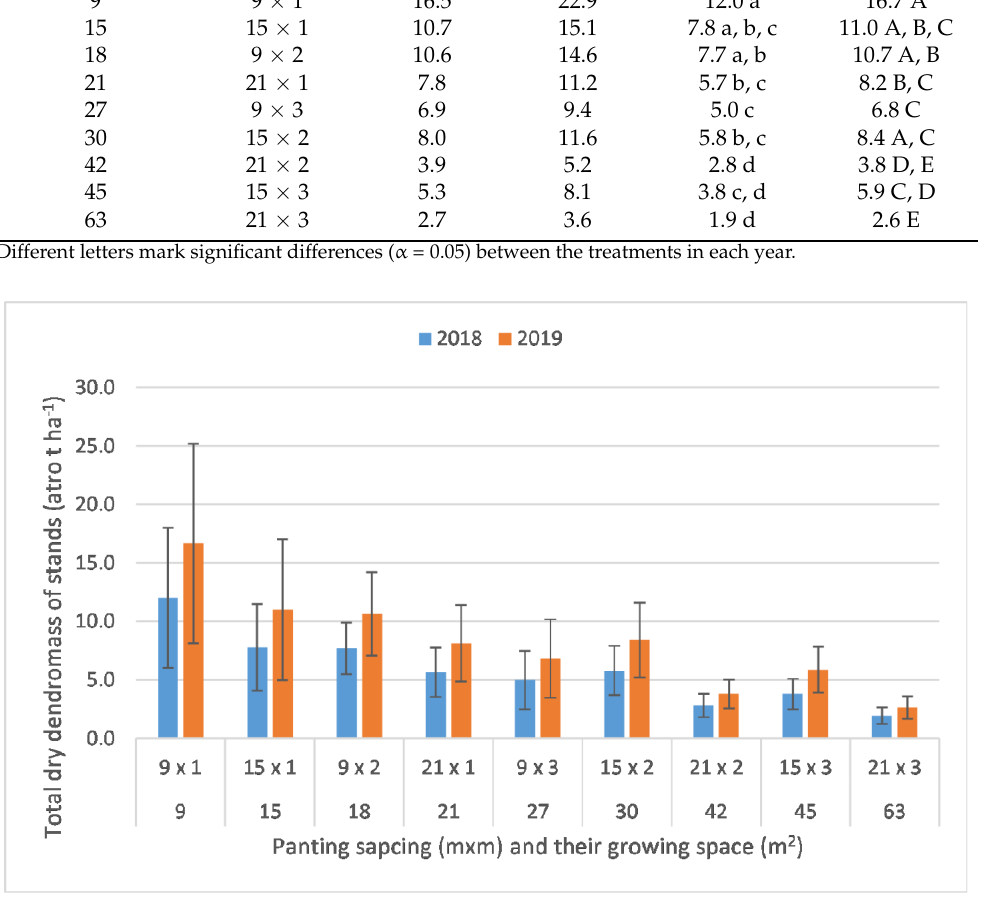
Figure 2. Total above-ground dry dendromass of agroforestry stands per hectare according to different tree spacings (α=0.05; 2018: n=272; 2019: n=263) .